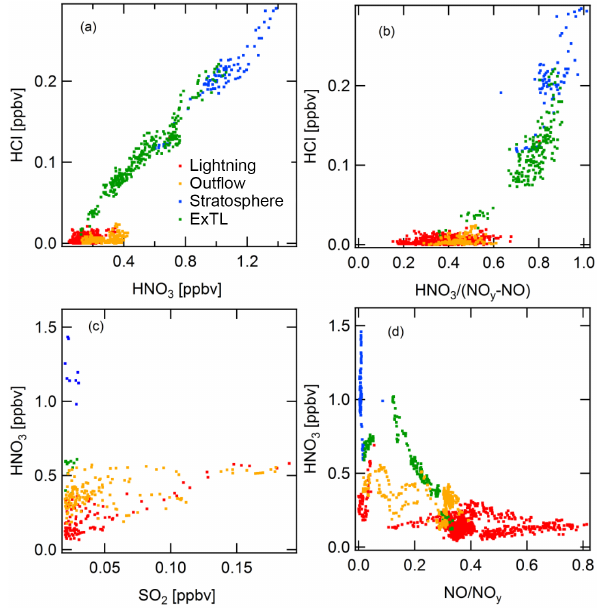
Figure 8. Tracer–tracer correlations of HCl, HNO 3 , SO 2 and NO / NO y and HNO 3 / (NO y − NO) are shown. The correlations are used to differentiate between tropospheric and stratospheric contri- butions to four different air mass compositions encountered dur- ing the flight on 11 September 2012. A lightning-influenced air mass (red), aged outflow (yellow), air from the ExTL (green) and a stratospheric air mass (blue) were encountered. While the red and yellow data show no HCl enhancement, SO 2 and NO / NO y are clearly enhanced. HCl and HNO 3 are strongly correlated in the stratosphere. In the region above the tropopause, the ExTL, mixed air was encountered, represented by the decreasing ratio of HNO 3 / (NO y − NO) with increasing HCl.